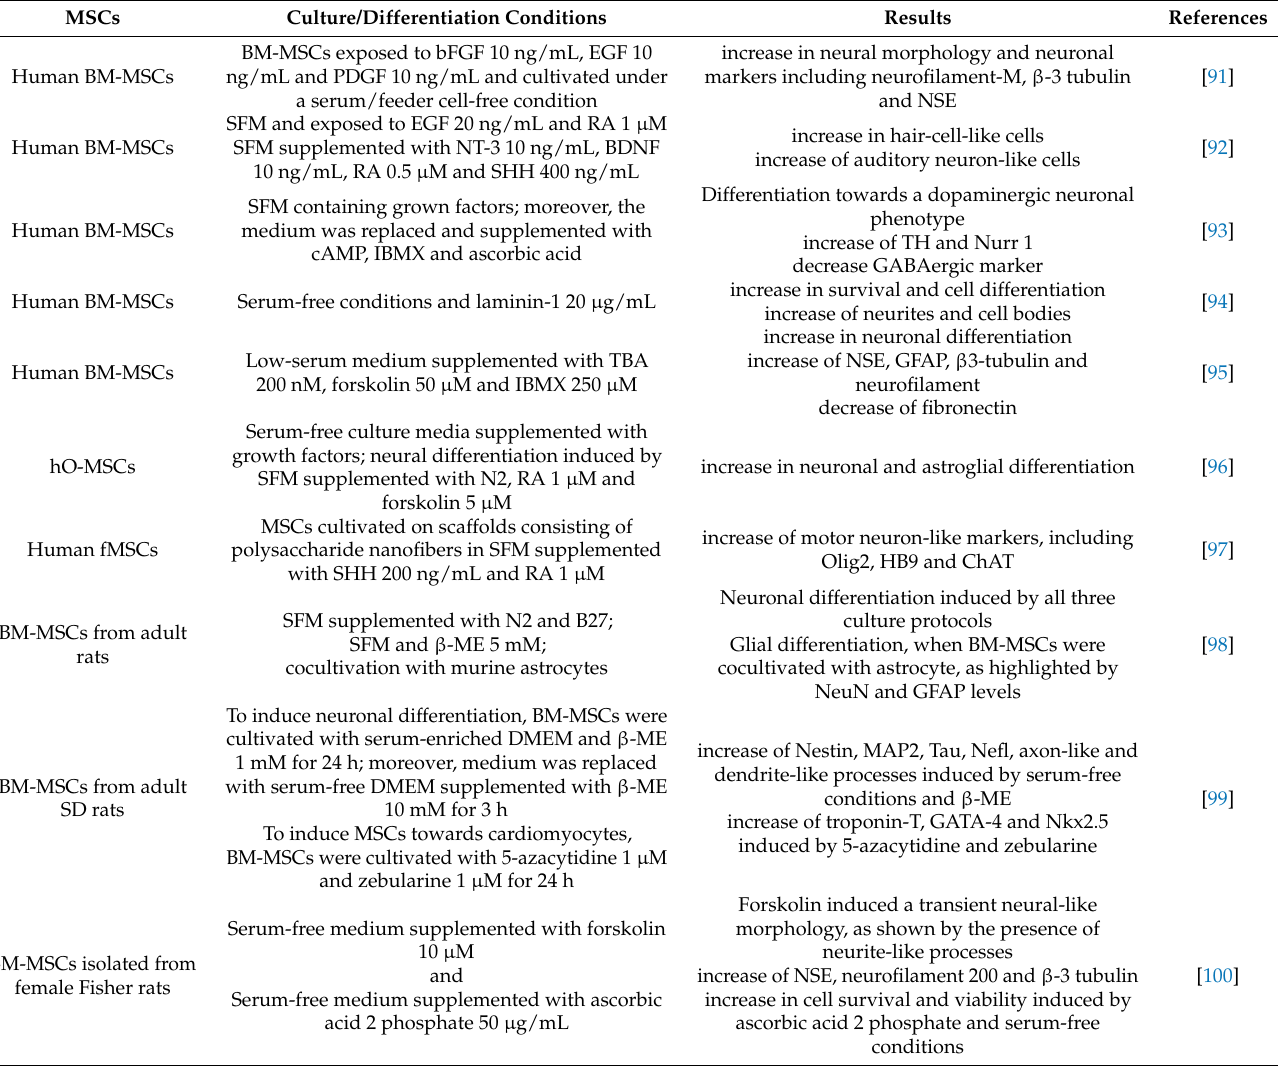
Table 6. Synthesis of the in vitro studies that demonstrated the effects on MSCs cultivated in serum- free medium supplemented with chemical agents used alone or combined with grown factors or other culture